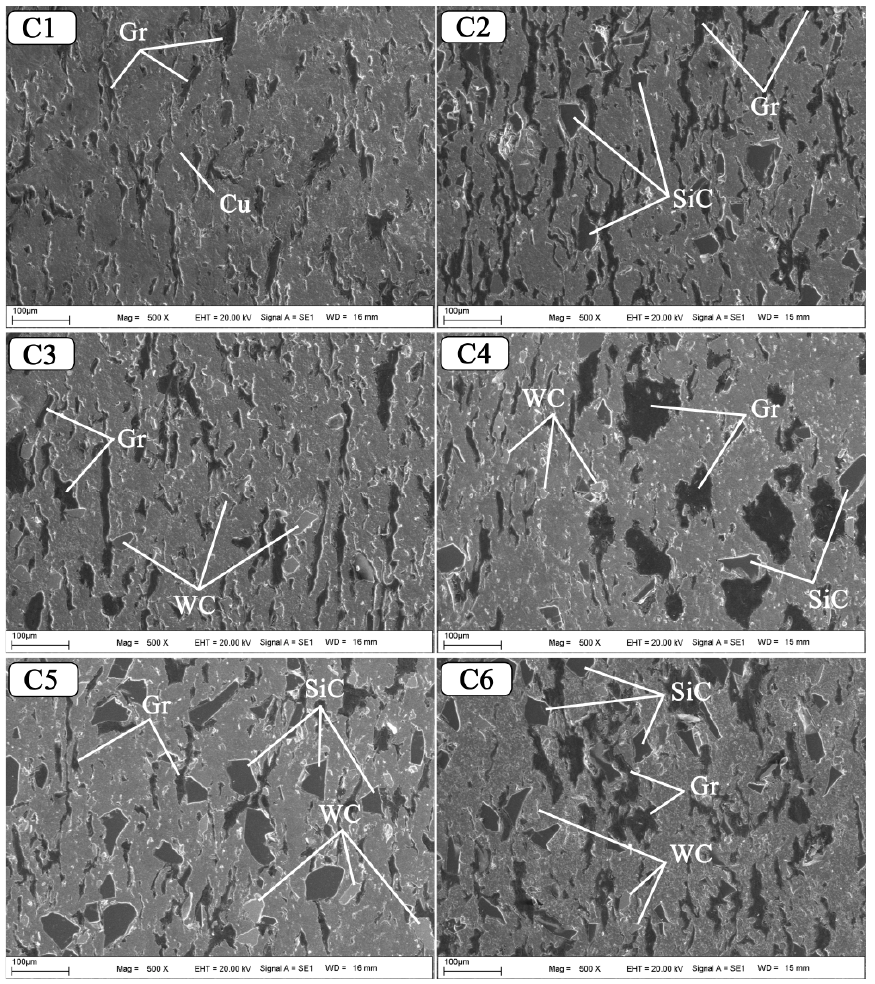
Figure 4. Composite SEM graphs manufactured at various reinforcement ratios.